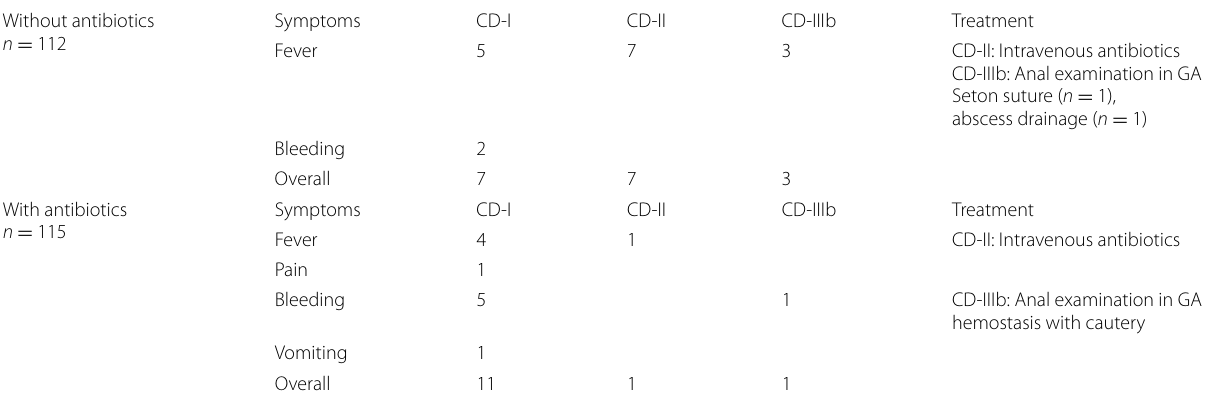
Table 2 Complications for children who had a full-thickness rectal biopsy performed with and without perioperative antibiotics along with type of